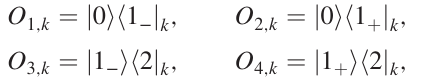
FIG. 11. Dimension of the physical subspace d line), the total number of basis states 4 N in our formulation (red dashed line), and the dimension of the basis from Ref. [55], 3 N ð 2 j 1 Þ N − 1 , for the simplest nontrivial truncation j max þ 1 = 2 (green dash-dotted line) as a function of system size. Inset: Fraction of the physical subspace with respect to the total amount of basis states.